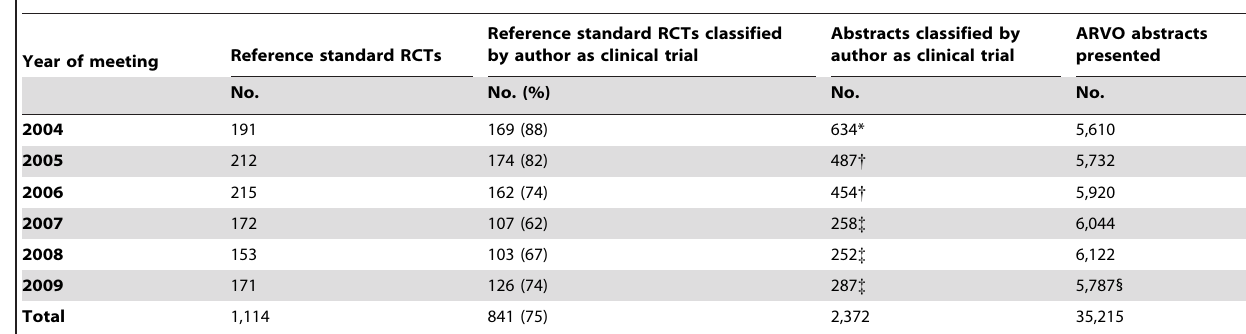
Table 1. Reference standard RCTs identified and RCTS identified by author as controlled trial by year of presentation at ARVO.